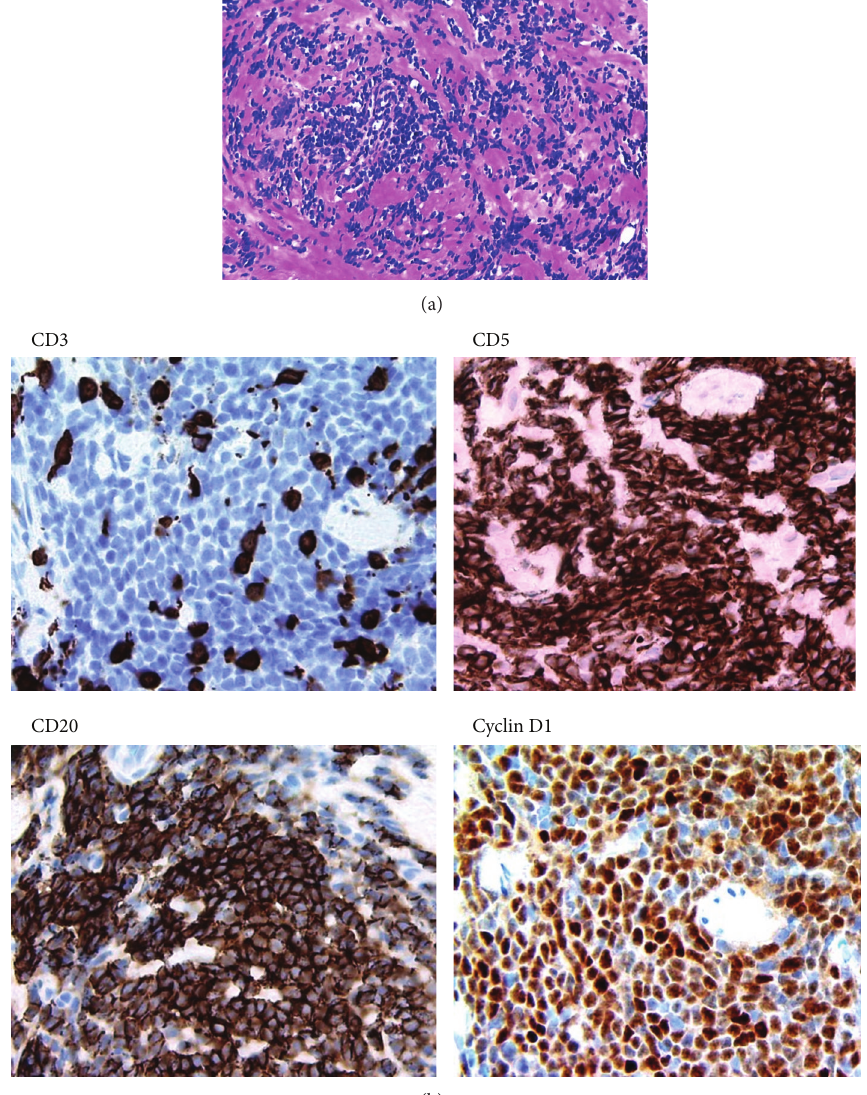
Figure 2: (a) Prostate mantle cell lymphoma, 20x hematoxylin and eosin. (b) Immunohistochemical stains for mantle cell lymphoma, 40x CD3, CD5, CD20, and cyclin